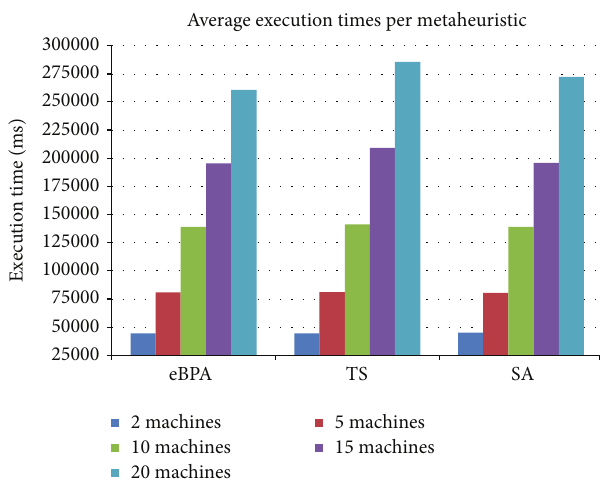
Figure 9: Average execution times per metaheuristic, per machine set, for the class of 2,500